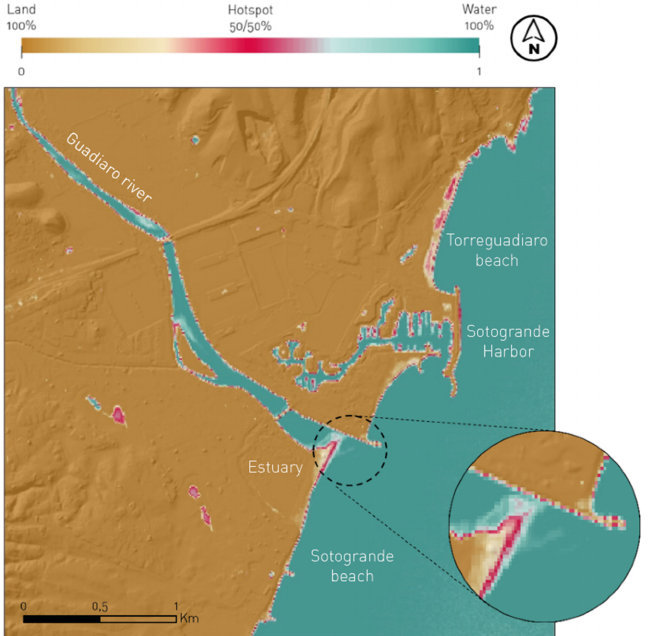
Figure 9. Variation rate of land/sea interface in the Guadiaro river mouth using Sentinel-2 L2A images and NDWI index between 2017 and 2020. Scale